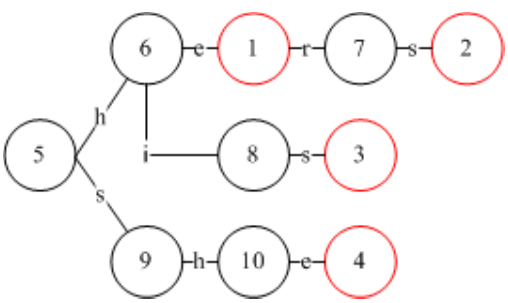
Figure 1. Parallel failureless Aho-Corasick (PFAC) machine based on four patterns: “he,” “hers,” “his,” and “she.”